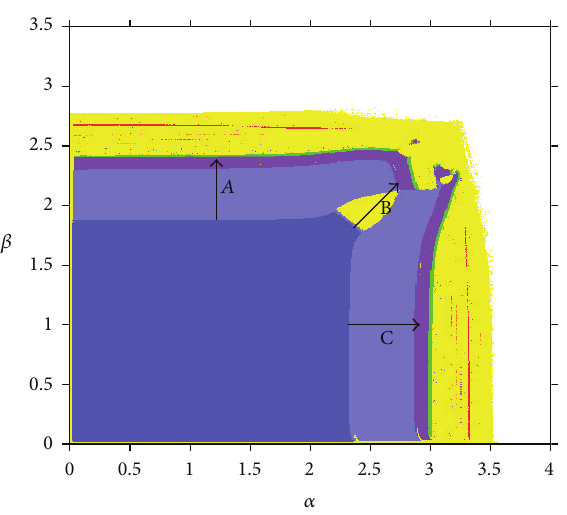
Figure 2: The parameter basin for 𝑑 = 0.1 .